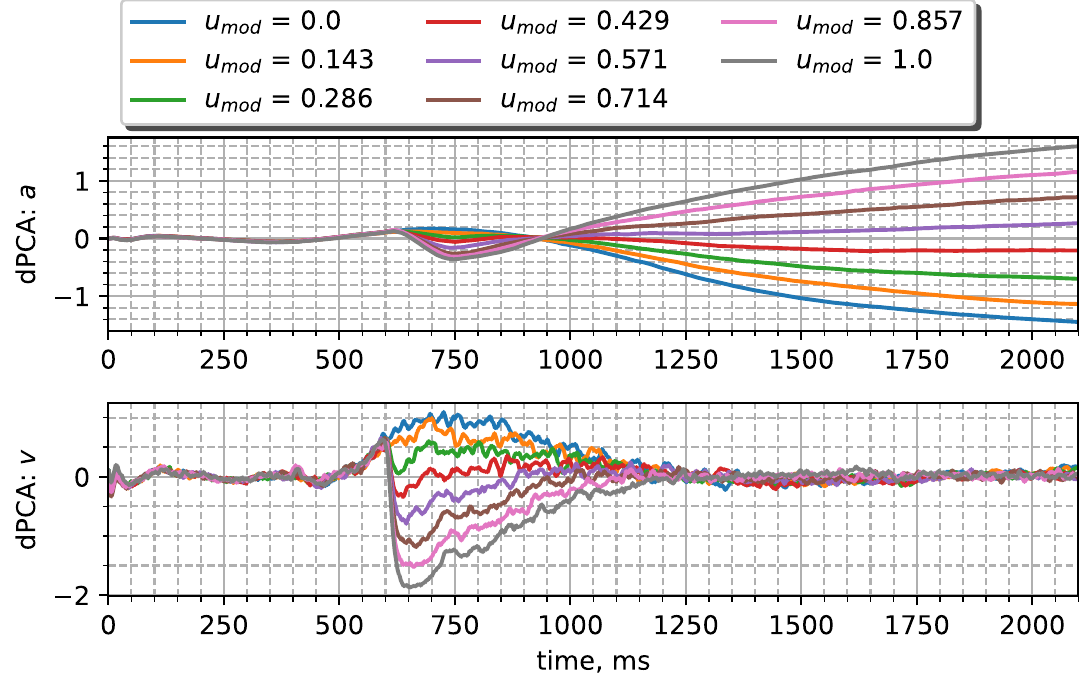
Figure 11. First stimulus demixed components obtained for the adaptation variables (top) and membrane potentials (bottom) during the GoRt task with different input stimuli. The network size is N = 256 , it is trained with the regularized loss function, and other parameters those shown in Table